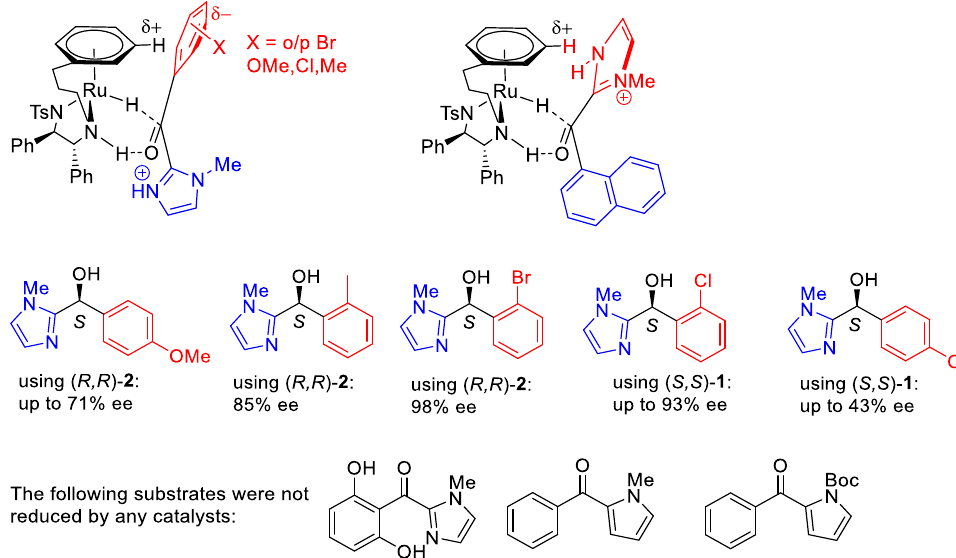
Figure 19. Products of ATH of an extended range of aromatic/heterocyclic ketones, and proposed modes of hydrogen transfer to substrates.